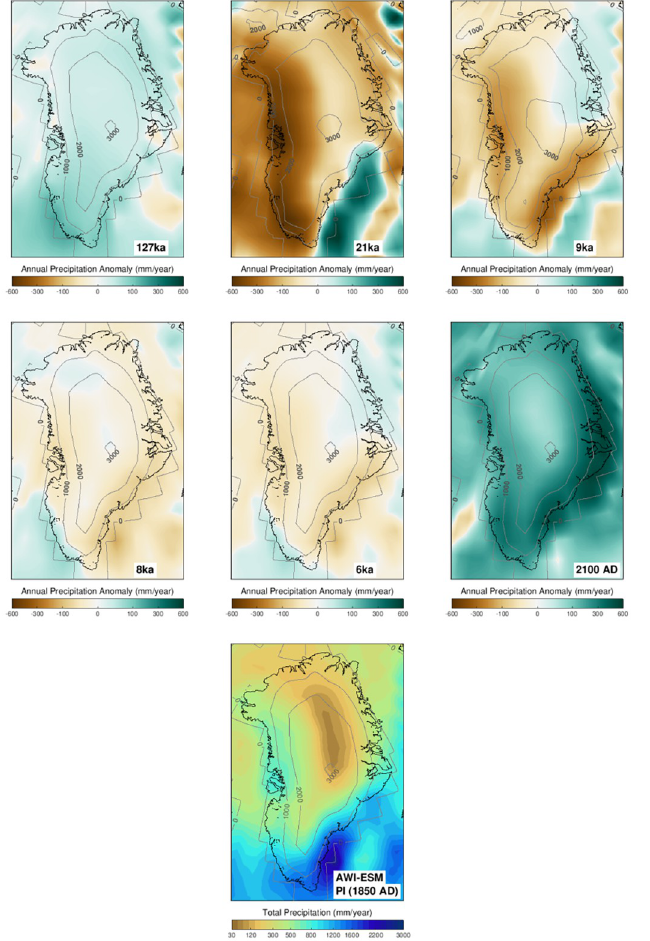
Fig 3. Same as Fig 2, but for annual mean